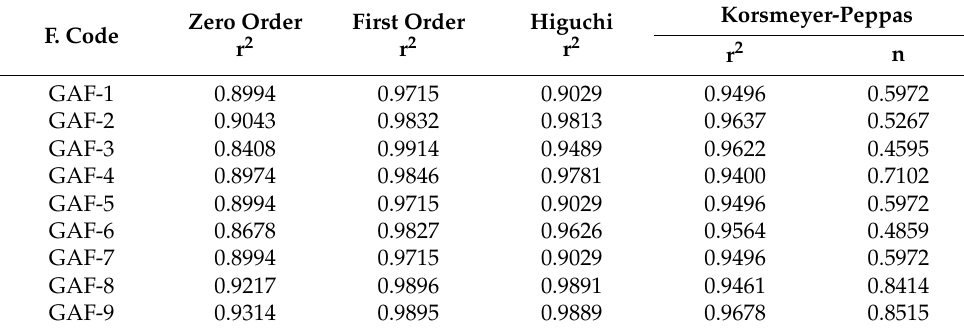
Table 3. Kinetic modeling release of KETM from GAcPAAc